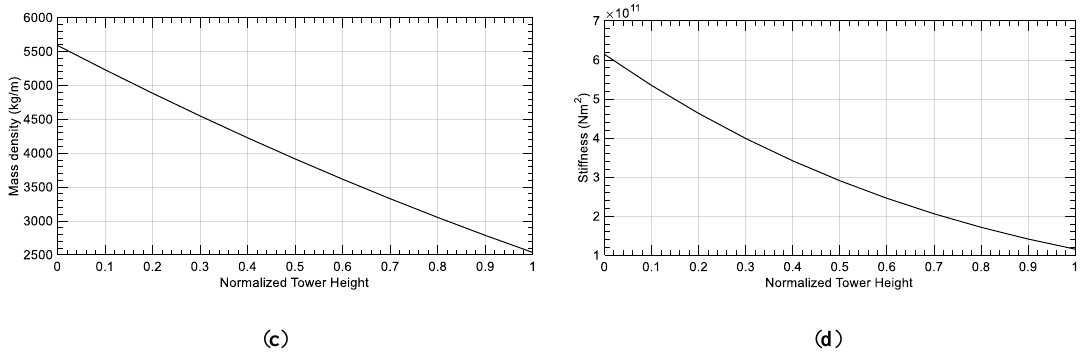
Figure 4. Blade structural properties: ( a ) Blade mass density distribution; ( b ) Blade stiffness distribution; ( c ) Tower mass density distribution; and ( d ) Tower stiffness distribution.